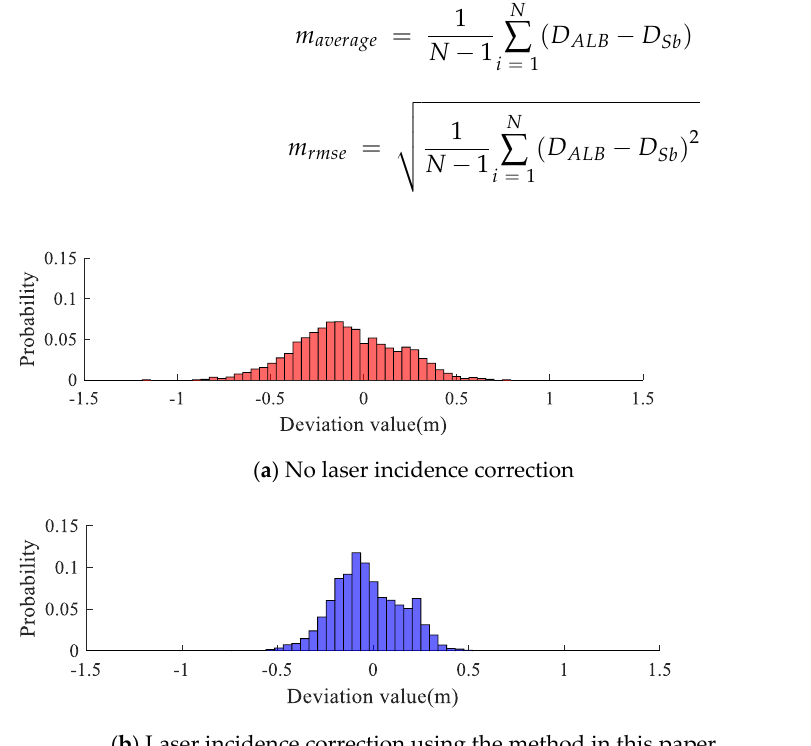
Figure 22. Probability distribution of depth deviation before water surface deviation correction vs. single-beam depth data in Experimental Area B.